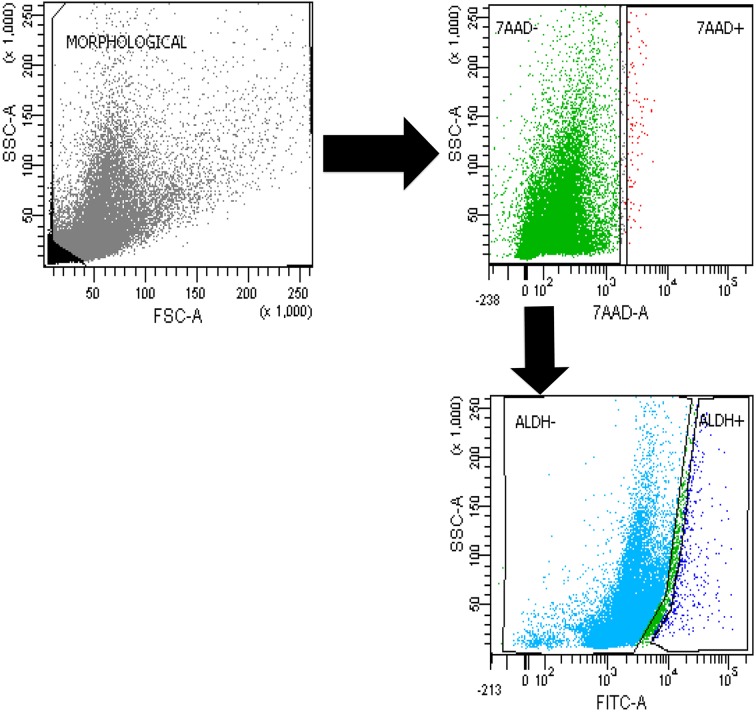
FACS analysis. Cytofluorimetric analysis of ALDHhigh cells in a case of lung myofibroblastic tumor.